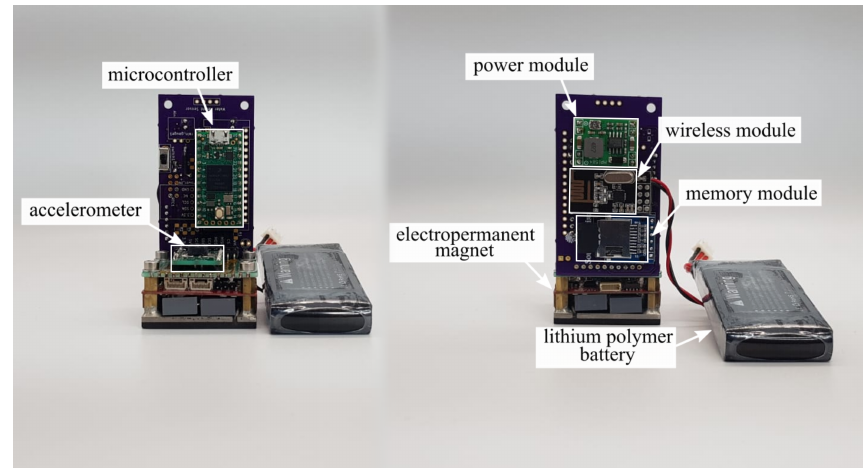
Figure 3. Constituent components of the sensor package.